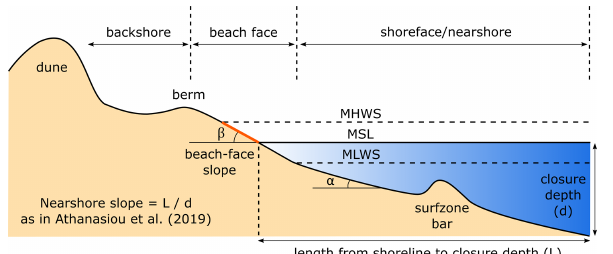
Figure 1. Schematic of a beach profile from the dune to the depth of closure, adapted from Coastal Engineering Research Center (1984). The beach-face slope (tan β ) that is mapped in this work is a proxy for the slope of the portion of the profile that is highlighted in or- ange, extending from mean sea level (MSL) up to mean high wa- ter springs (MHWS). The beach-face slope complements the global dataset of nearshore slopes presented in Athanasiou et al. (2019) that represents the slope extending from the depth of closure up to